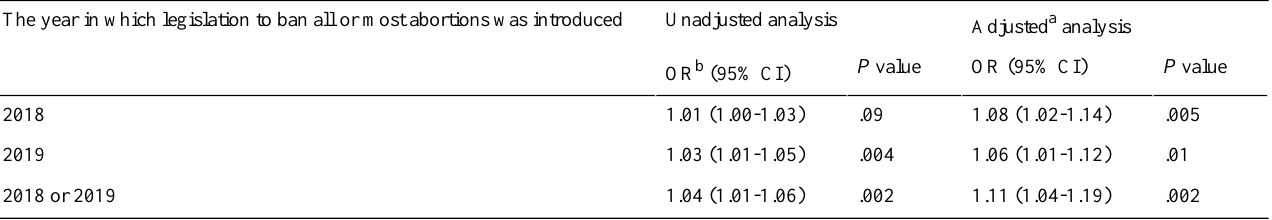
Table 2. Associations between the number of crisis pregnancy centers in each state and the District of Columbia and legislation proposed in 2018 and January-July 2019 to ban all or most